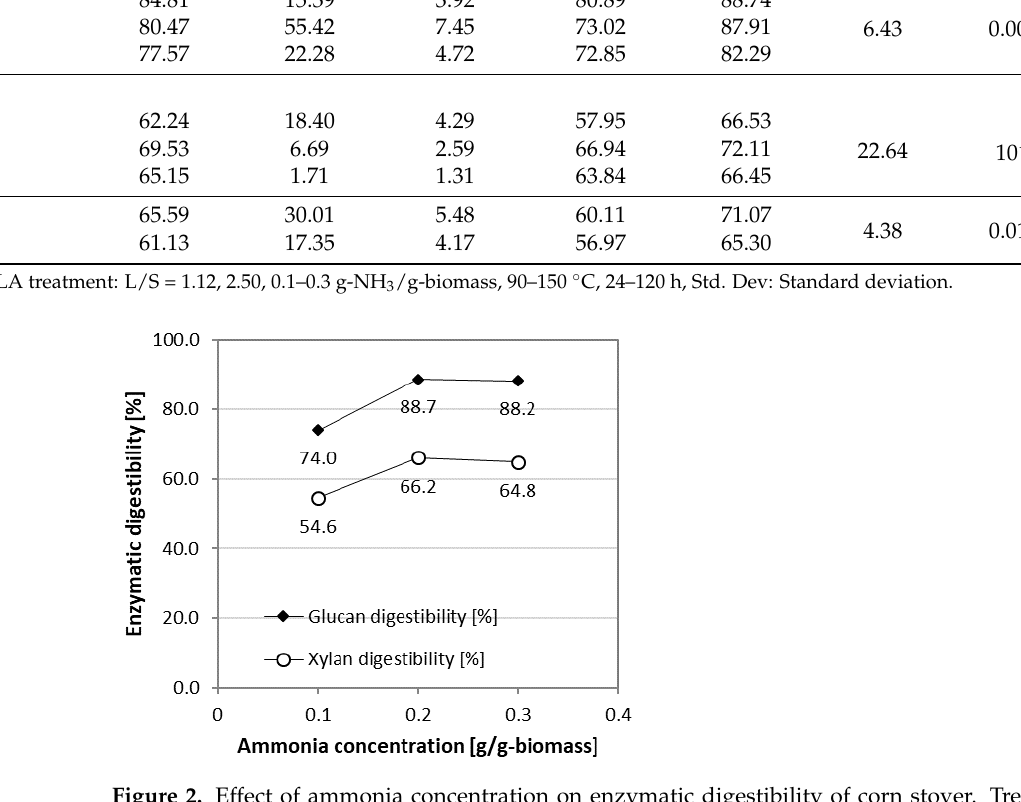
Figure 2. Effect of ammonia concentration on enzymatic digestibility of corn stover. Treatment conditions as follows. Extremely low-liquid ammonia treatment: L/S = 1.12, 0.1–0.3 g-NH 3 /g-biomass, 120 ◦ C, 24 h. Enzymatic hydrolysis conditions: CTech2; 15 FPU/g-glucan loading; 50 ◦ C; 150 rpm; hydrolysis time, 72